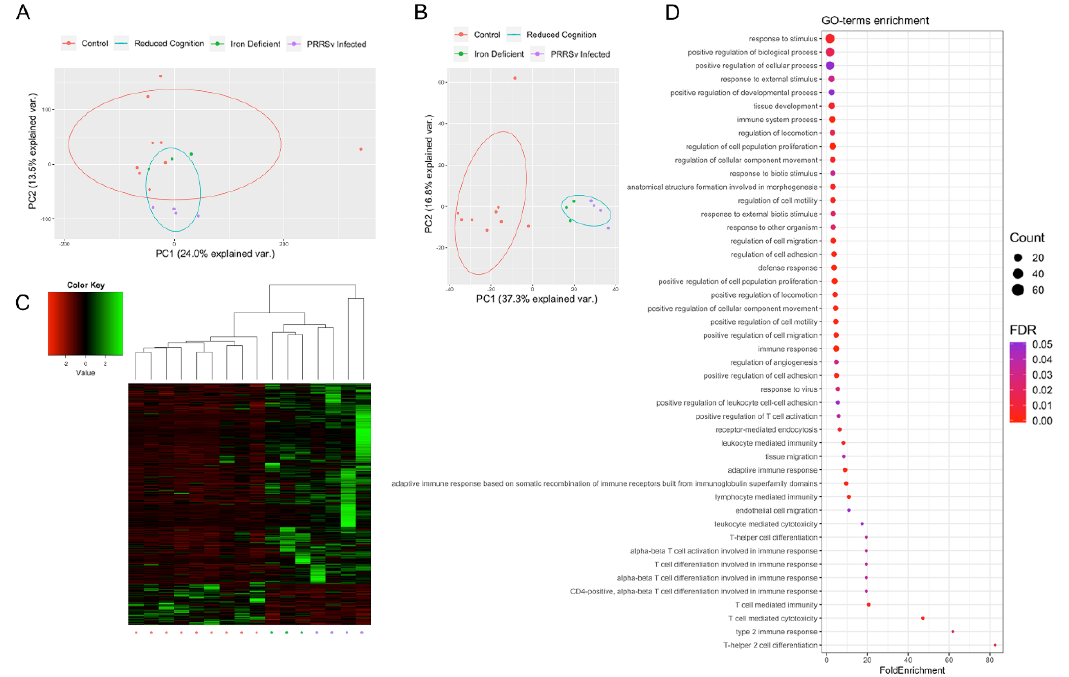
Figure 1. Alteration of Hippocampal Gene Expression Patterns. Principle component analysis (PCA) based on the expression level of ( A ) all tested genes and ( B ) DEGs. ( C ) Heatmap of the expression levels of the 420 DEGs, represented as z-scores. ( D ) Identified GO terms enriched for